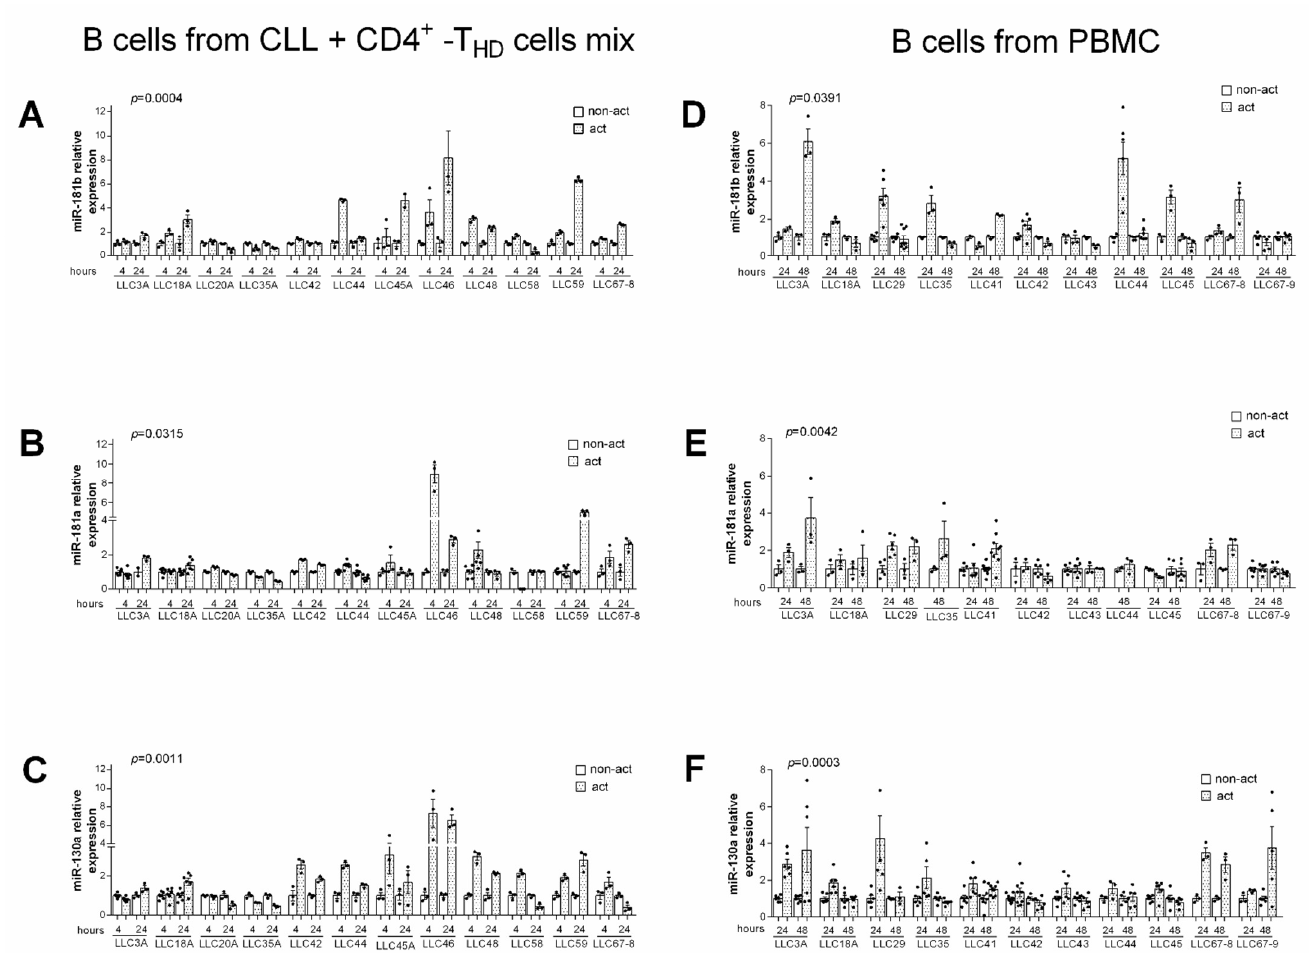
Figure 1. Exogenous activation of T cells increases miR-181b , miR-181a, and miR-130a expression levels in Chronic Lymphocytic Leukemia (CLL) cells. ( A – C ) Relative gene expression values in purified CLL cells co-cultured with activated vs. non-activated T cells. Purified CLL cells were mixed with either non-activated or activated (by anti-CD2, -CD3, -CD28 antibodies) T cells (CD4+) from healthy donors (HD) at a T/B ratio of 1:1. After 4 and 24 h CLL were re-purified and assayed for gene expression. ( D – F ) Relative gene expression values in purified CLL cells isolated from activated or non-activated peripheral blood mononuclear cells (PBMCs) from CLL patients. PBMC were activated as described above and then cultured for an additional 24 or 48 h. Relative expression values were determined by RT-qPCR; miRNAs data were normalized to the endogenous references RNU44 with the 2 − ∆ ct method. For each patient, the relative expression of miRNAs was normalized to the level of non-activated sample. Data are presented as means ± SEM and technical replicates are shown for each sample as black dots ( • ). p -values were calculated using Wilcoxon test in activated vs. non-activated CLL cells.